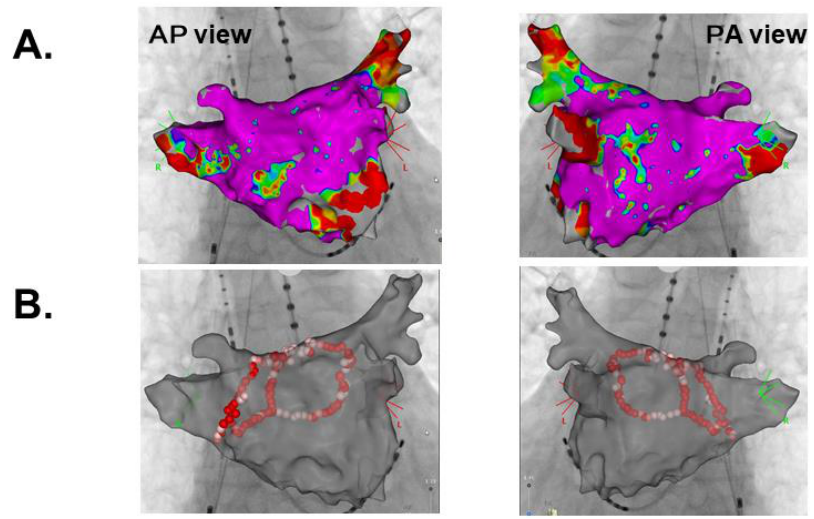
Figure 2. Left atrial voltage mapping ( A ) and ablation lines ( B ). AP, Anterior Posterior; PA, Posterior Anterior.